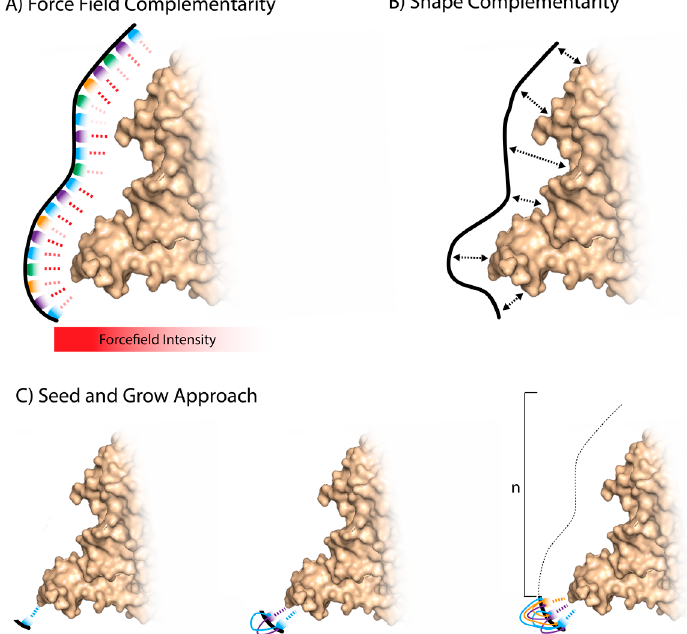
Figure 3. Simplified visualization of the molecular dynamics used in aptamer selections. ( A ) Force fields, the algorithmically calculated potential energies between atomic components of a nucleotide sequence and a target, are algorithmically calculated and represented here as a dashed red line. The differential opacity represents the variable favorability of each interaction, which is later translated into a docking score; ( B ) shape complementarity, a simplified representation of the nucleotide sequence interacting with a target based on spatial orientation; ( C ) the seed and grow approach, a fragment-based method. A single nucleotide is matched with a target and single nucleotides are added in sequence. A probability distribution is used to measure the interactions between the target and linked nucleotides. The target in this figure is derived from crystal structure PDB